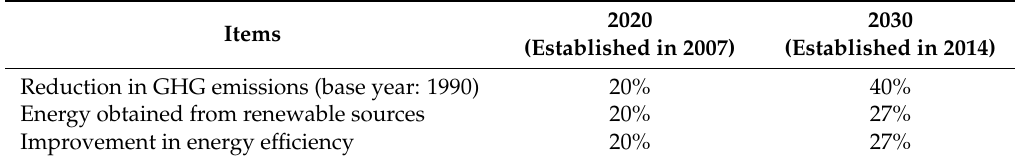
Table 1. Policy targets regarding the energy and emission